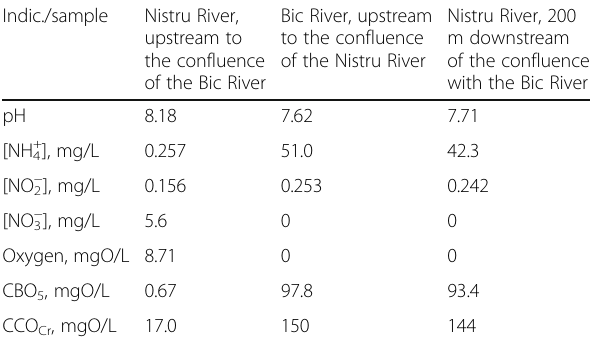
Table 1 Indicators of water quality of the Nistru and Bic Rivers at their confluence Indic./sample